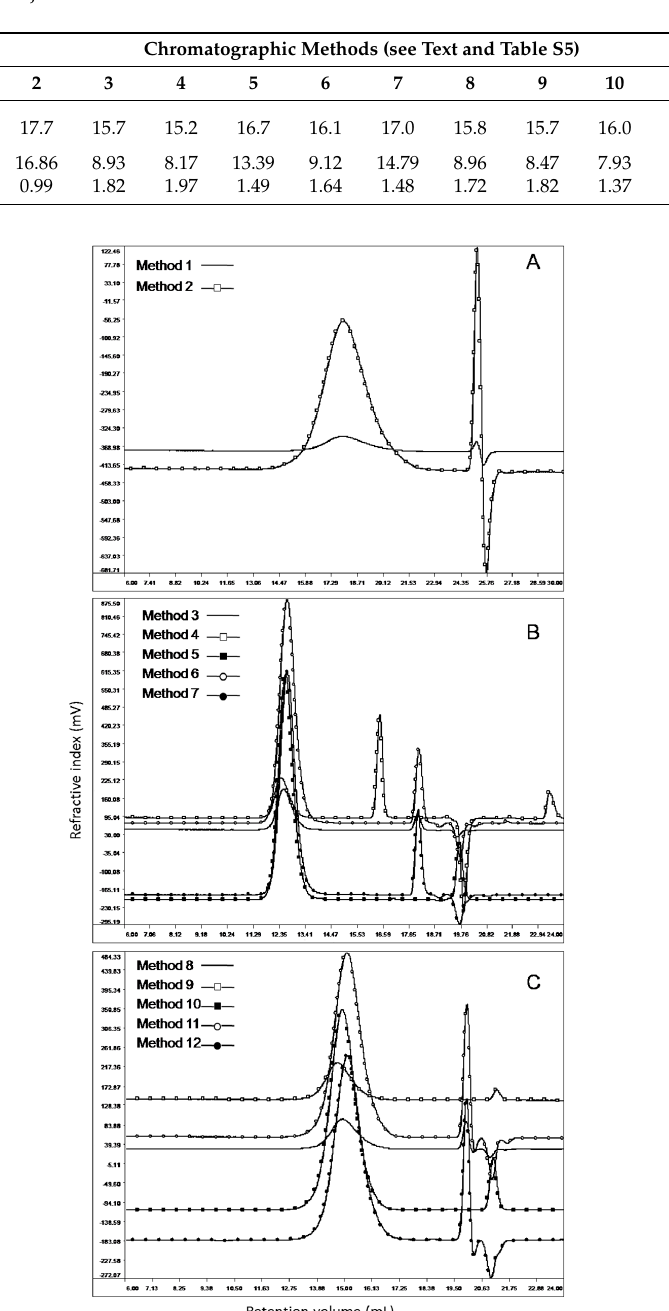
Figure 3. Phase 2: Overlay view of USP Heparin Sodium Identification RS chromatographic profiles in 12 distinct chromatographic systems. Panels: ( A ) Methods 1 and 2; ( B ) Methods 3–7; ( C ) Methods 8–12.